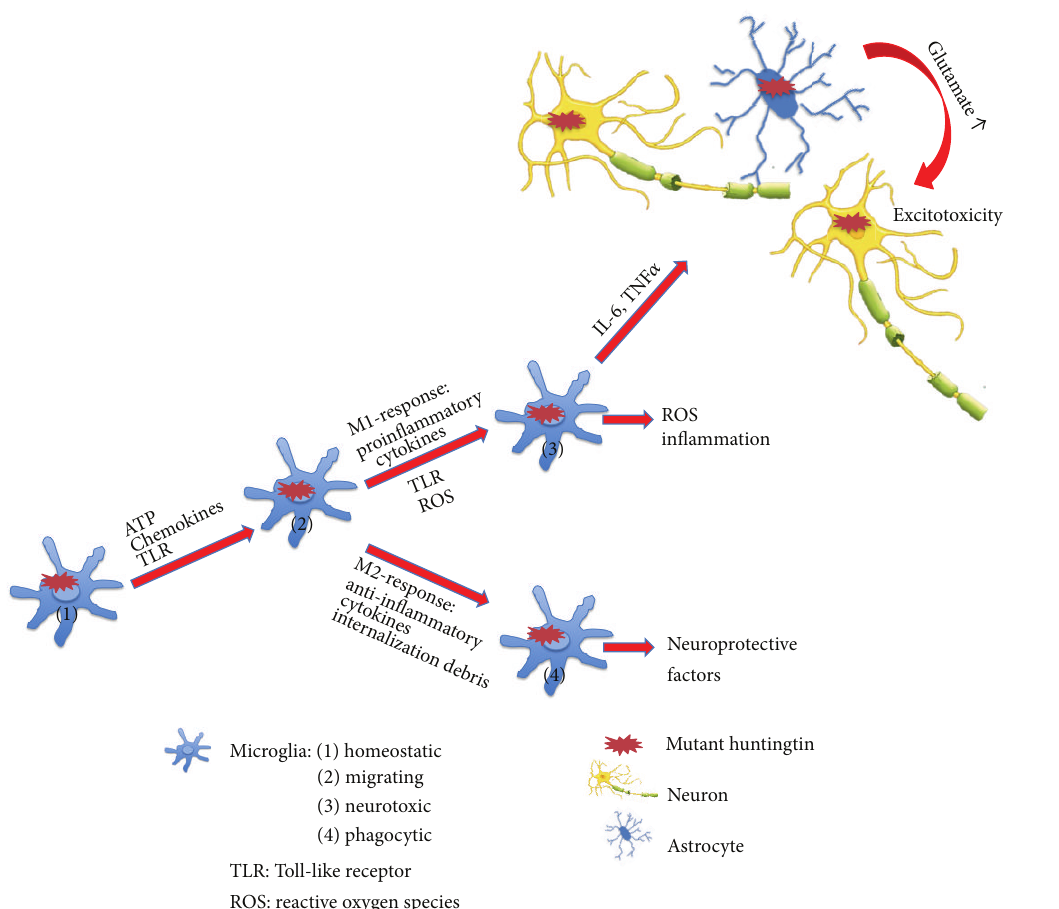
Figure 2: Neuronal glia interactions in Huntington’s disease. Microglia/macrophages are essential for host defense and can trigger M1 or M2 responses. The dichotomous M1/M2 concept implies that M1 cells induce Th1 cells that produce proinflammatory cytokines like IFN- 𝛾 , while M2 cells induce Th2 cells that are associated with IL-4, IL-5, and IL-10 supporting anti-inflammatory effects or antibody production. Aggregates of mutant huntingtin (mhtt) are found in neurons, astrocytes, and microglia. With a decreased protective function due to fewer glutamate transporters, mhtt-containing astrocytes may contribute to excitotoxicity. Consequently, there is glutamate excitotoxicity and glutamate-induced apoptosis causing neurodegeneration. At the same time, mhtt enhances microglia function and leads to microglia activation. Migrating microglia secrete proinflammatory cytokines (e.g., TNF 𝛼 ) and nitric oxide thus contributing to neurotoxicity. Yet, simultaneously, phagocytic microglia may also produce neuroprotective